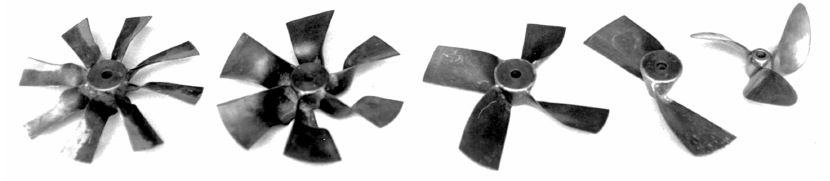
Figure 6. Experimental impellers with fixed blades. Source: [5].